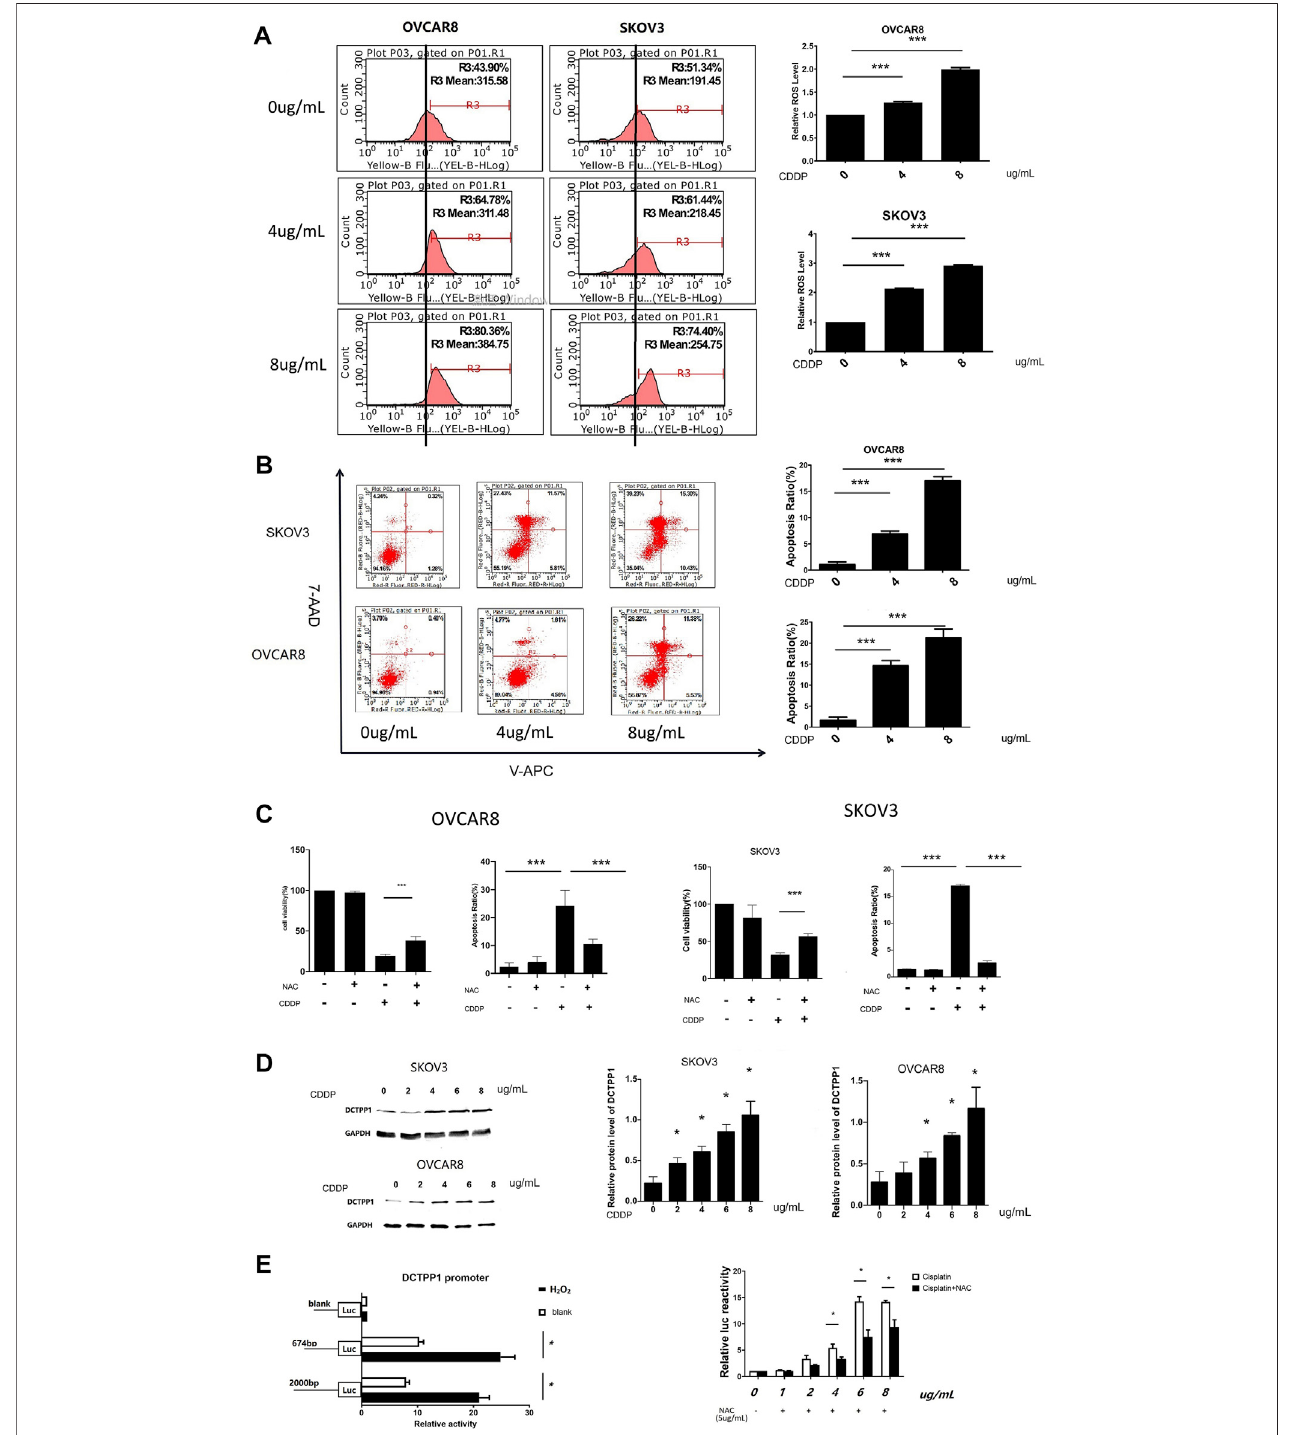
FIGURE2| DCTPP1expressioncouldbeinducedbycisplatinthroughROSgeneration. (A) Thelevelofreactive oxygenspecies(ROS) wasdetected usingDHEin OVCAR8 and SKOV3 cells treated with different concertration cisplatin (0, 4, and 8 μ g/ml); ***, p < 0.001; B. Cell apoptosis ratio was analyzed with fl ow cytometry in OVCAR8 and SKOV3 cells treated with different concertration cisplatin (0,4,8 μ g/ml); ***, p < 0.001; (C) Statistical analysis of cell viability and apoptosis ratio exposed to cisplatin (4 μ g/ml) with or without NAC(5 μ g/ml). * p < 0.05; **, p < 0.01; ***, p < 0.001; (D) Western blot analysis of SKOV3 and OVCAR8 cells treated with cisplatin (0,2,4,6,8 μ g/ml).* p < 0.05;**, p < 0.01;***, p < 0.001; (E) luciferasereporterassayanalysisofDCTPP1promoterluciferasereportersinSKOV3cellstreatedwithdifferent concertration cisplatin (1, 2, 4, 6, and 8 μ g/ml) and NAC(5 μ g/ml),* p < 0.05.